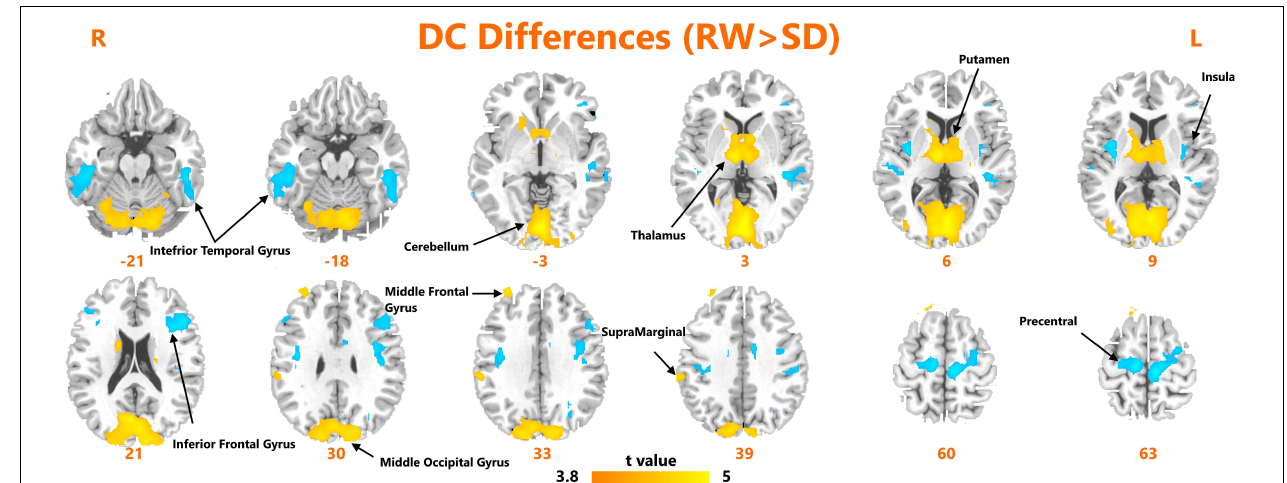
FIGURE 1 | Areas of significant degree centrality differences between resting wakefulness state and sleep deprivation state.